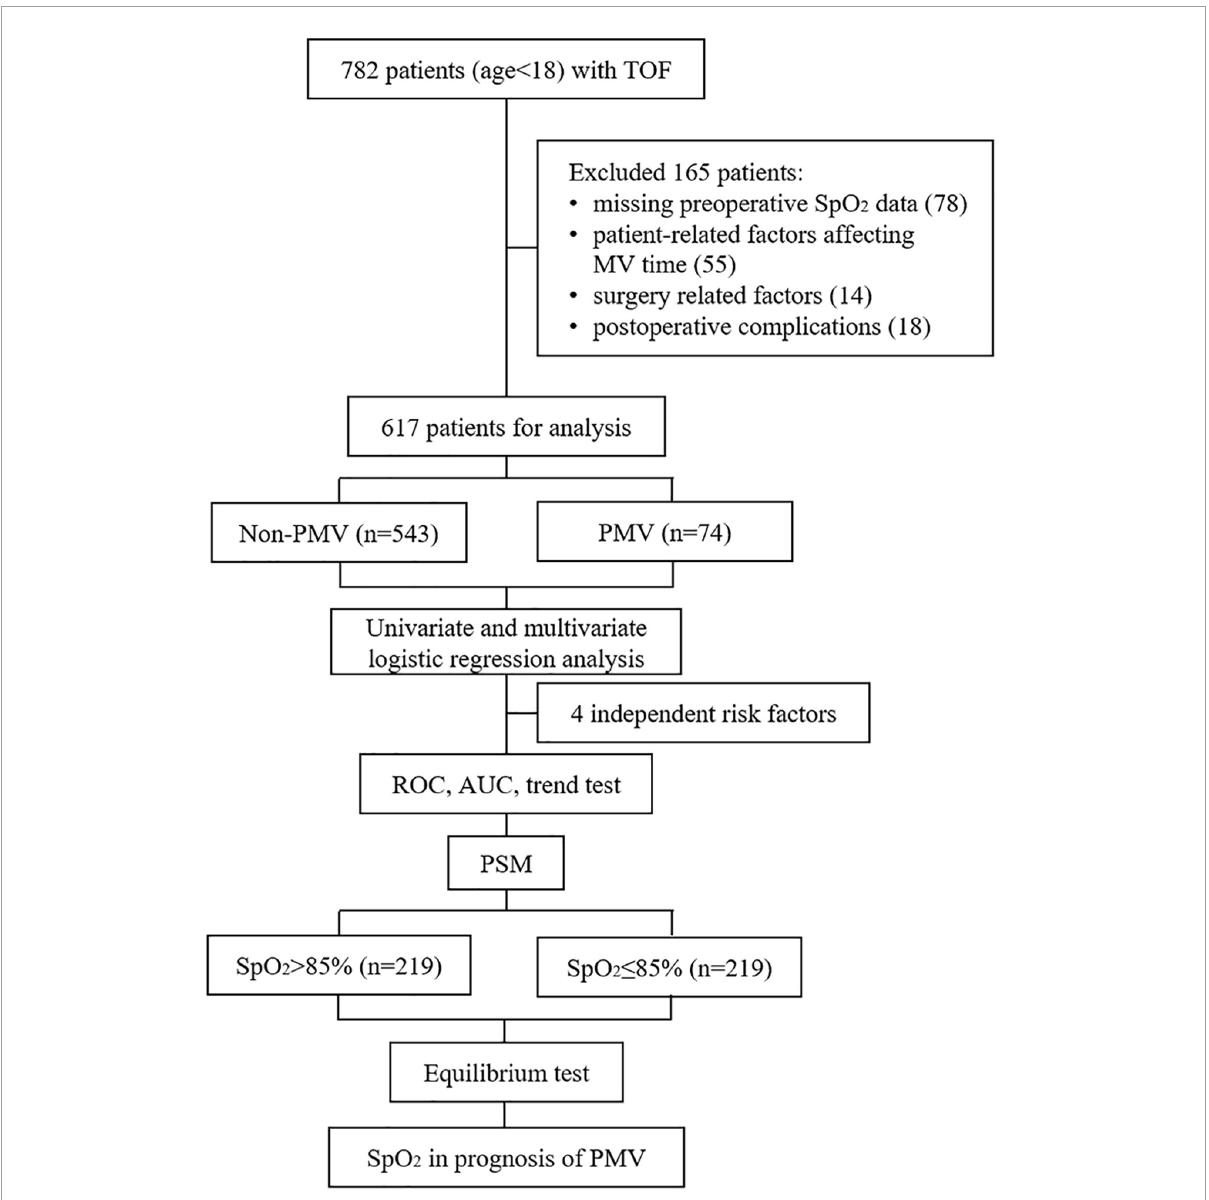
FIGURE1 Flowchart of this study. TOF, Tetralogy of Fallot; SpO 2 , pulse oximeter oxygen saturation; MV, mechanical ventilation; PMV, prolonged mechanical ventilation; ROC, receiver operating characteristic; AUC, area under the curve; PSM, propensity score matching.